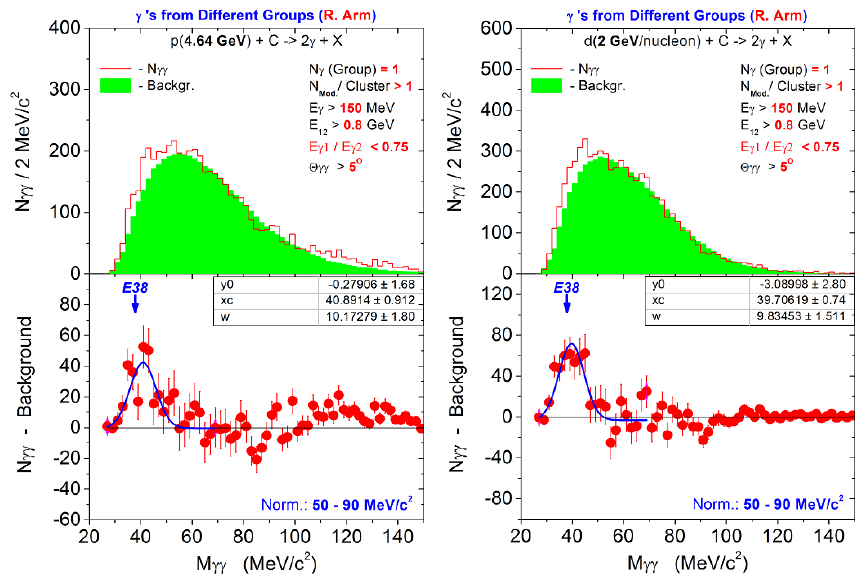
Figure 4. The same as in Fig. 3 but for γγ pairs selected from di ff erent groups (only 1 photon in each group, and when the photon triggers several modules), at E γ Min = 150 MeV, at the sum of the energies of two photons, E 12 > 0 . 8 GeV, at the ratio of their energies E γ